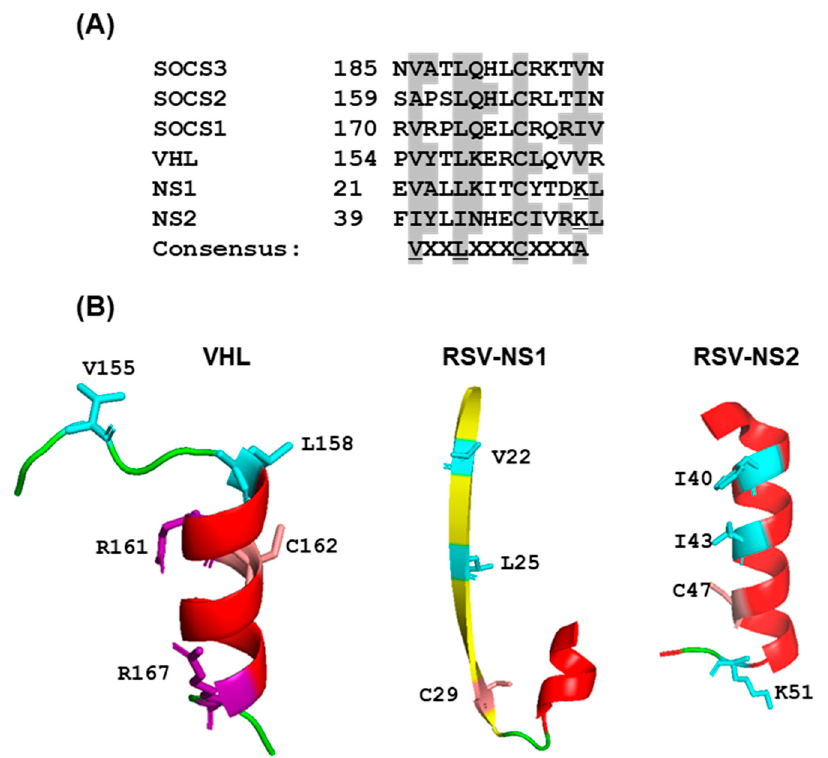
Figure 7. Putative BC box homology motif in NS proteins. ( A ) Distant homology of portions of NS1 and NS2 with known BC boxes, adopted from Elliott et al. 2007 [56] is shown by highlighted residues. The underlined K (Lys) is unique in NS1/1. ( B ) Actual crystal structure of this part of VHL (PDB 1VCB), RSV NS1 (PDB 5VJ2), and RSV NS2 (7LDK) showing lack of secondary structural similarity. The residues highlighted in panel A are also shown as side chains in PyMol presentation.